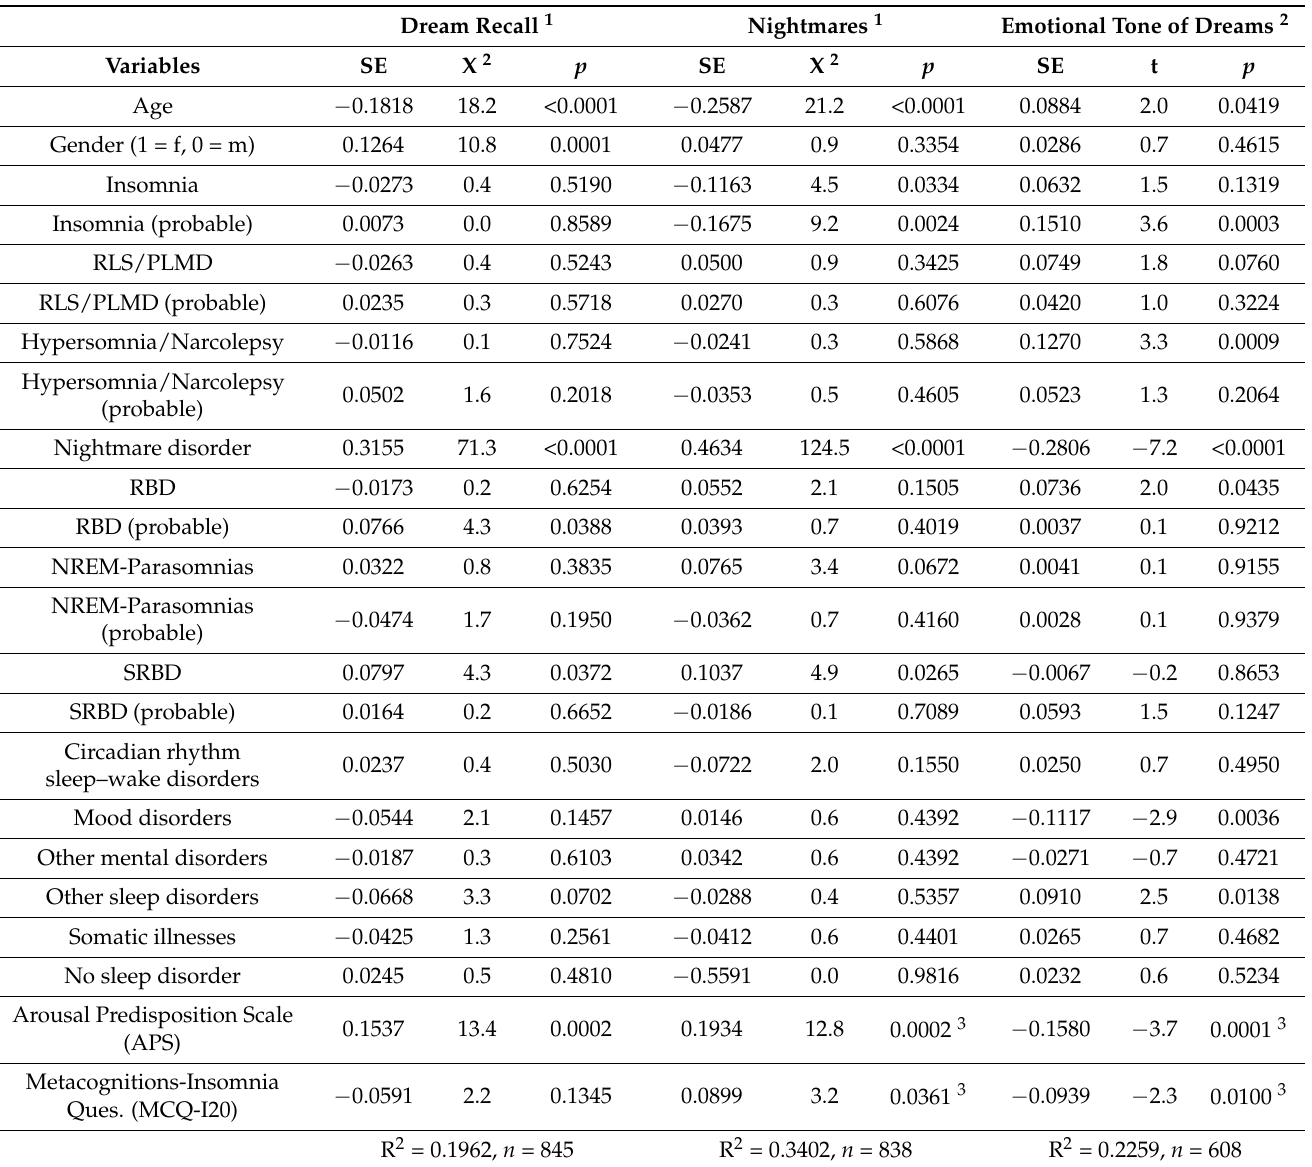
Table 5. Regression analyses for dream